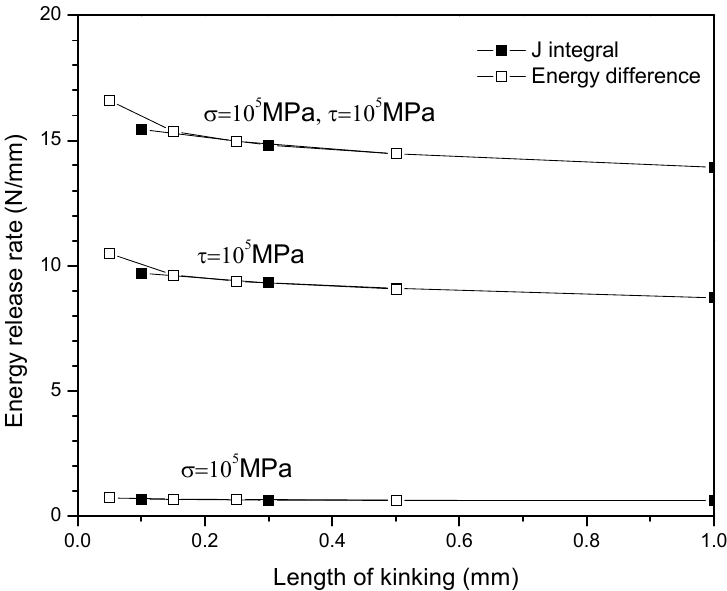
Figure 4. Determination of energy release rates as the length of kink crack approaches zero.